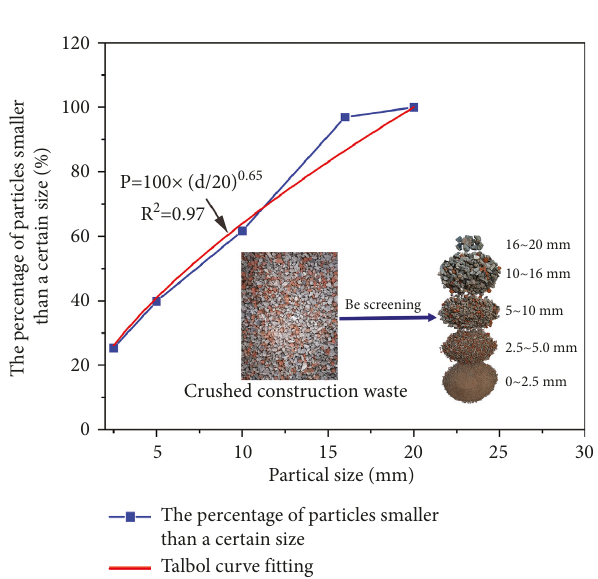
Figure 2: Particle size grading curve of crushed construction